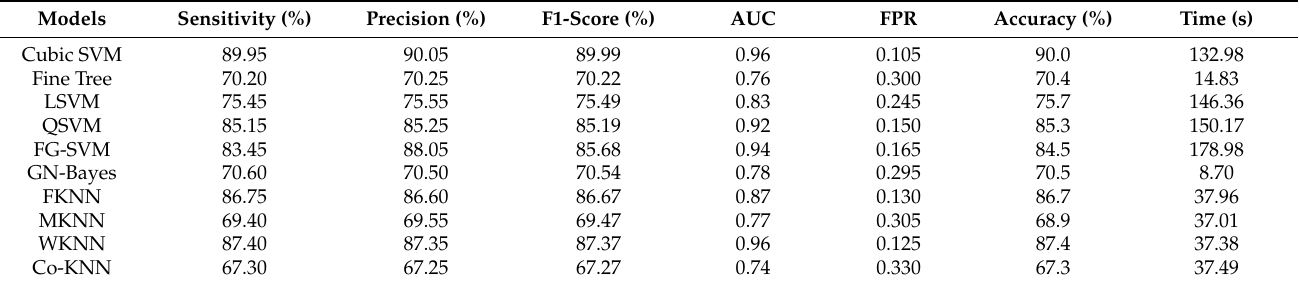
Table 4. Classification results using MEWOA on MobilenetV2 deep features for CBIS-DDSM.